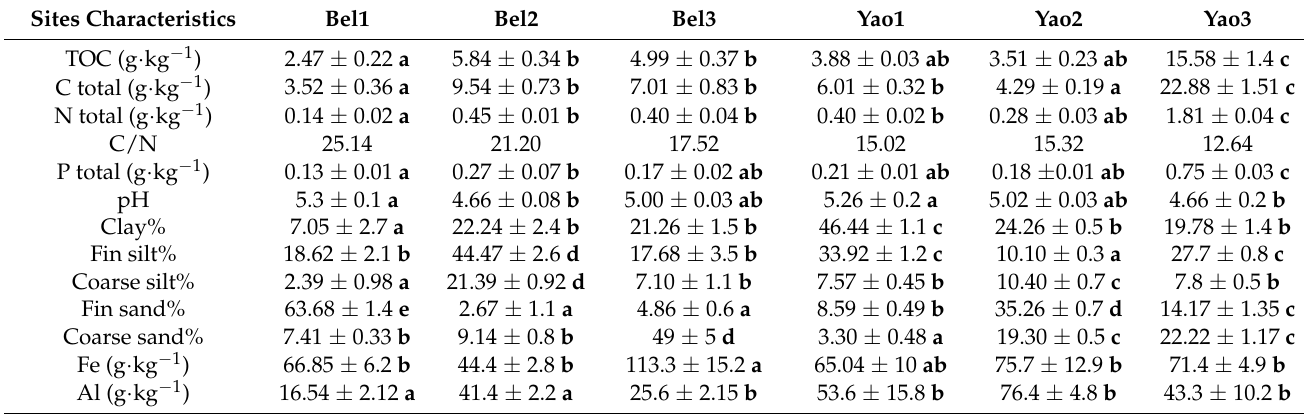
Table 1. TOC: Total Organic Carbon, C tot , N tot , and P tot : Total C, N and P, Total Fe, Al: Total Iron, Aluminum content, ( n = 5, mean ± SD). For each parameter, values followed by different letters differ significantly with p < 0.05 with Tukey HSD test. Sites Characteristics Bel1